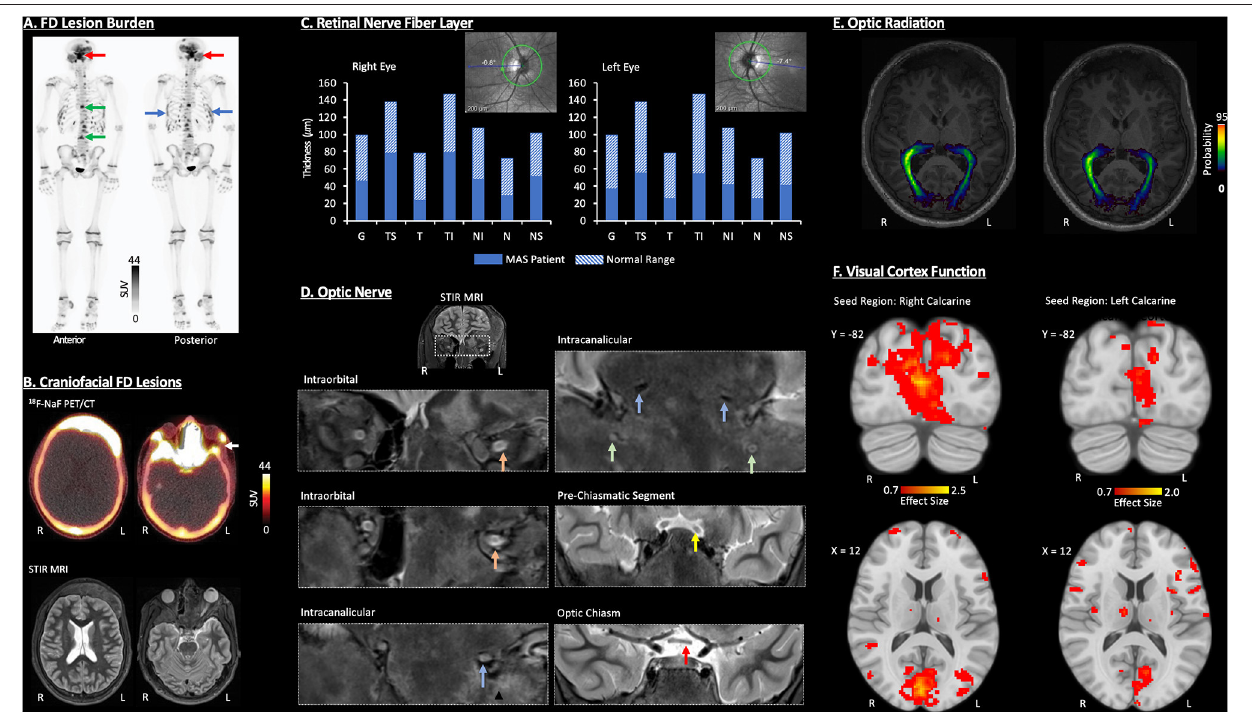
FIGURE 1 | Visual pathway characterization in a pediatric MAS patient. All imaging data were acquired without sedation and at 3-months post-decompression surgery of the left optic nerve. (A) Whole-Body 18 F-Sodium fluoride positron emission tomography/computerized tomography ( 18 F-NaF PET/CT) identified FD lesions within craniofacial bones (red arrow), spine (green arrow), and ribs (blue arrow). (B) A combination of 18 F-NaF PET/CT and non-contrast MRI identified FD in multiple craniofacial regions (i.e., frontal bones, nasal turbinates, sphenoid bone, greater wing of the sphenoid, zygomatic arch, mastoid, mandible occipital bone, and right maxillary sinus). The white arrow denotes the segment of bone tissue removed during decompression surgery of the left optic nerve. (C) Retinal nerve fiber layer (RNFL) loss was evident in both eyes as revealed by OCT, with slightly greater abnormalities in the left eye. G, Global Average; TS, Temporal-Superior; T, Temporal; TI, Temporal-Inferior; NI, Nasal-Inferior; N, Nasal; NS, Nasal-Superior. (D) Coronal, non-contrast short-tau inversion-recovery (STIR) MRI showed neuropathy in the left optic and trigeminal nerves. Inferior displacement and flattening were detected within intraorbital (orange arrow) and intracanalicular (blue arrow) segments of the left optic nerve. Bilateral trigeminal nerve (V2) inferior displacement, compression, and atrophy was also present (green arrow). At the pre-chiasmatic level (yellow arrow), inferior displacement, mild atrophy, and subtle hyperintensity indicate mild edema or gliosis of the left optic nerve. Left optic nerve atrophy was present in the optic chiasm (red arrow). (E) DTI revealed a loss of white matter fiber density, as defined by the probability distribution, of the left optic radiation relative to the right. The optic radiation is defined as the axonal bundle projecting between the lateral geniculate nucleus and primary visual cortex. (F) Resting-state functional connectivity was reduced for the left primary visual cortex compared to the right. Further details on all data acquisition and analysis procedures as well as additional study findings have been provided in Supplemental Information .